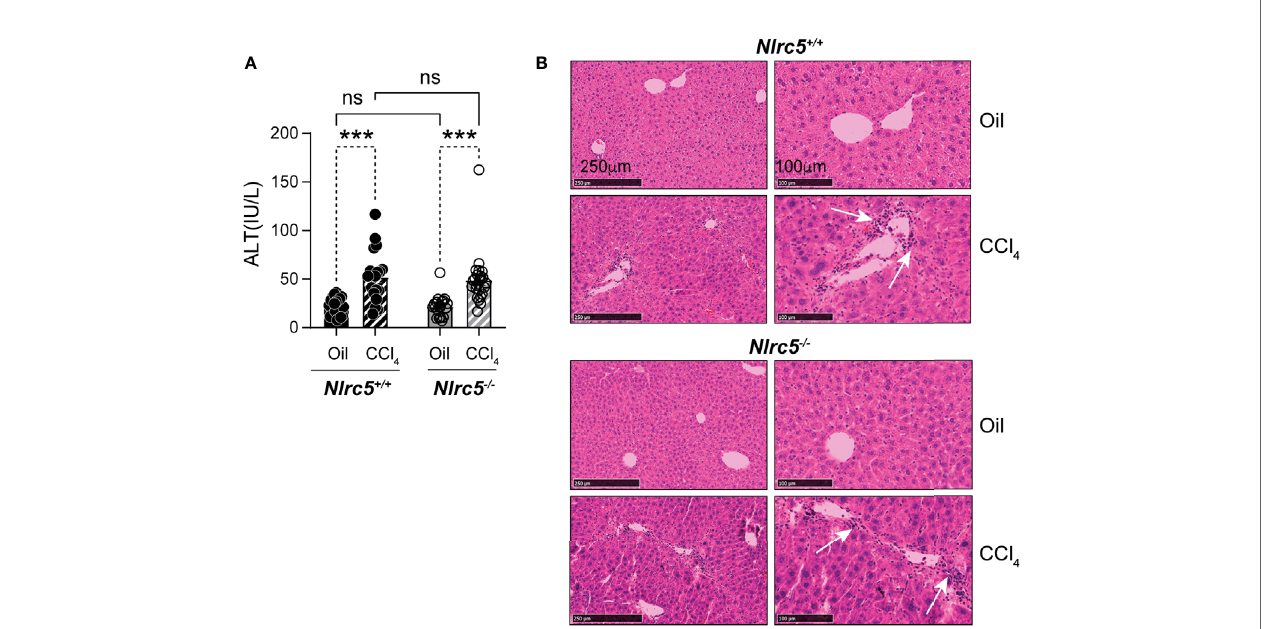
FIGURE 1 | Loss of NLRC5 does not exacerbate liver damage caused by chemical injury. (A) Serum ALT levels in NLRC5-de fi cient and control mice following 5 weeks of treatment with CCl 4 or corn oil (vehicle). Data shown are mean ± standard error of mean (SEM) from 4-5 mice per group from two separate experiments. Statistical signi fi cance was calculated by two-way ANOVA with Tukey ’ s post-hoc test: ***p < 0.001, ns, not signi fi cant. (B) Images of hematoxylin and eosin-stained sections of the livers, representative of 4-6 mice per group are shown. Magni fi ed images (right) show comparable changes in hepatocyte morphology and mononuclear cell in fi ltration (arrows) in CCl 4 -treated NLRC5-de fi cient and control